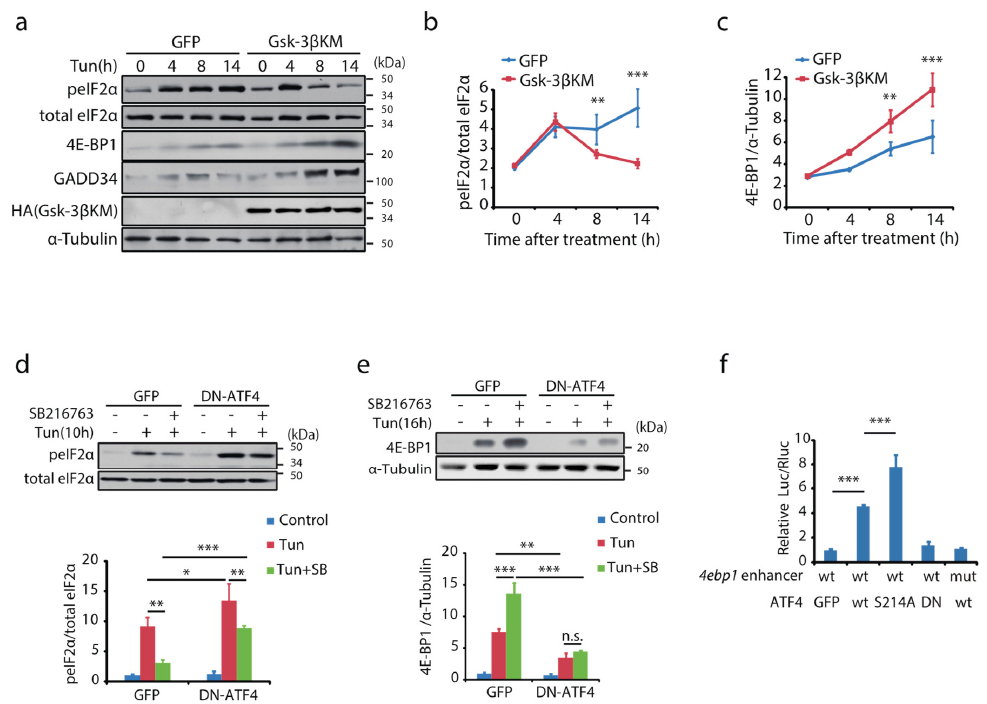
Figure 4. Gsk-3 modulates transcription targets of ATF4 and phosphorylation of eIF2 α . MIN6 cells expressing GFP or HA-Gsk-3 β KM were incubated with tunicamycin for the indicated time periods. Protein lysates were analysed by Western blotting. ( a ) Representative blot images obtained using the same gel. Representative changes in ( b ) peIF2 α and ( c ) 4E-BP1 expression relative to the basal are graphically shown as mean ± SD (n = 3); ** p < 0.01, *** p < 0.001 by two-way ANOVA followed by Bonferroni’s post hoc test. The effects of retrovirus-mediated expression of DN-ATF4 on ( d ) peIF2 α and ( e ) 4E-BP1 in MIN6 cells treated with Gsk-3 inhibitor were examined by Western blotting. Graphical data represent the relative abundance of peIF2 α and 4E-BP1 as mean ± SD (n = 3). * p < 0.05, ** p < 0.01, *** p < 0.001 by one-way ANOVA followed by Bonferroni’s post hoc test. ( f ) MIN6 cells were transfected with luciferase reporters with the SV40 promoter and an Eif4ebp1 gene segment with C/EBP: ATF composite sites or their mutants (Supplementary Figure S5b) together with pcDNA3.1-GFP, pcDNA3.1-wt, -S214A, or -DN-ATF4. Luc/Rluc is graphically summarised. Data are shown as mean ± SD. n = 4 for each experiment; *** p < 0.001 by one-way ANOVA followed by Bonferroni’s post hoc test. 2.7. Gsk-3 Inhibition Modulates the Regulation of Protein Translation under ER Stress We explored the functional relevance of ISR modulation by Gsk-3 inhibition. The effects of Gsk-3 inhibition on overall protein translation were assessed in MIN6 cells by incorporating AHA. As shown in Figure 5a, 4 h incubation with tunicamycin similarly suppressed protein translation in the presence or absence of the Gsk-3 inhibitor. At 10 h,